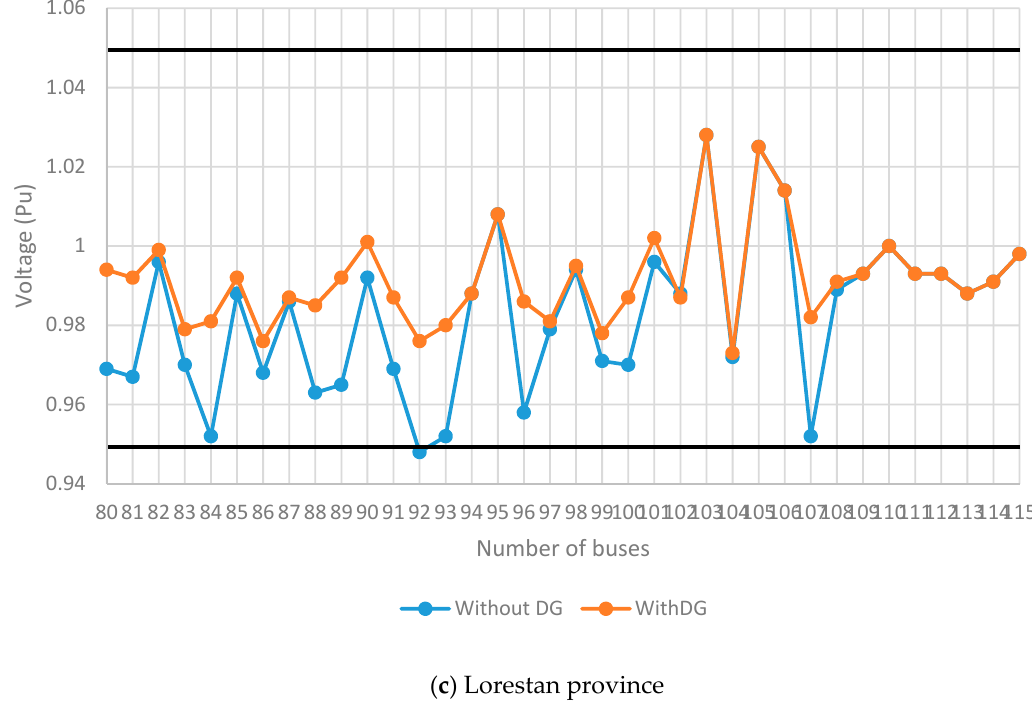
Figure 4. The voltage profile of buses for: ( a ) Markazi province; ( b ) Hamedan province; ( c ) Lorestan province.